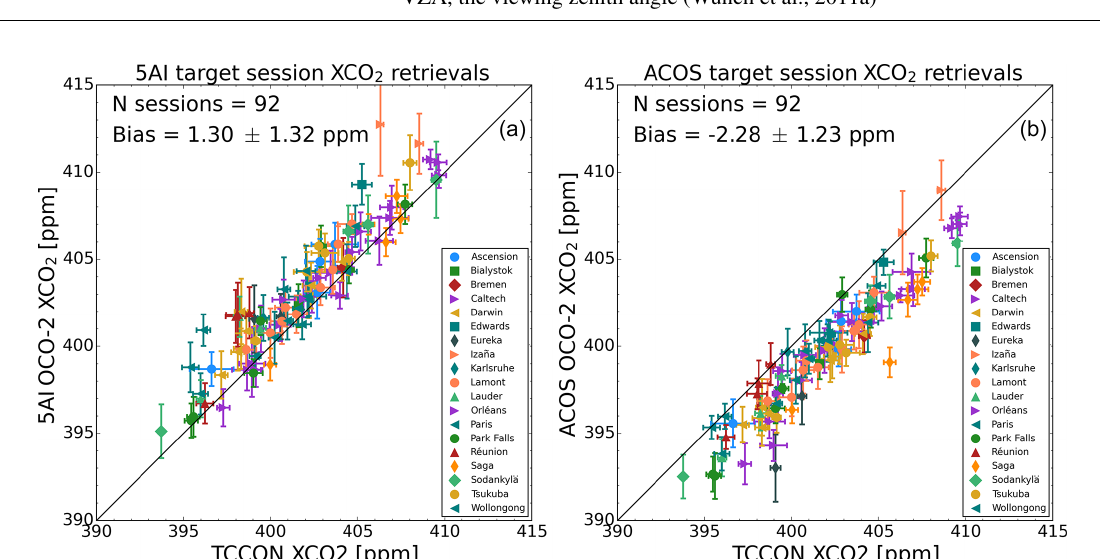
Figure 3. The 5AI (a) and raw ACOS B8r (b) OCO-2 target X CO sounding results are averaged for every target session. Markers show the session average for OCO-2 and TCCON X CO the standard